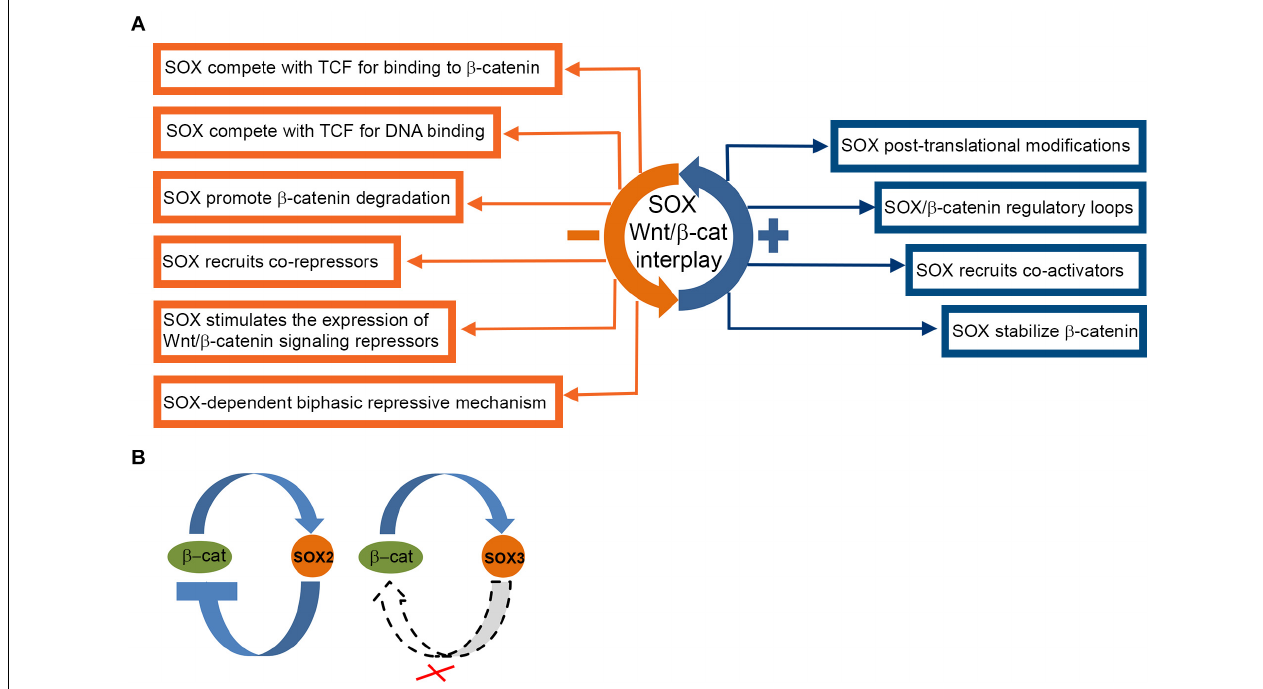
FIGURE 5 | Complex interactions of SOX proteins and Wnt/ β -catenin signaling pathway. (A) Overview of SOX interactions with Wnt/ β -catenin pathway (Bernard and Harley, 2010; Kormish et al., 2010; Hagey and Muhr, 2014). SOX protein repression and activation mechanisms are indicated by orange and blue boxes, respectively. (B) SOX2 and SOX3/ β -catenin crosstalk in NT2/D1 cells. Proposed model of mutual regulation of SOX2 and SOX3 and β -catenin in NT2/D1 cells (Mojsin et al., 2015). Crossed dashed lines indicate absence of regulatory